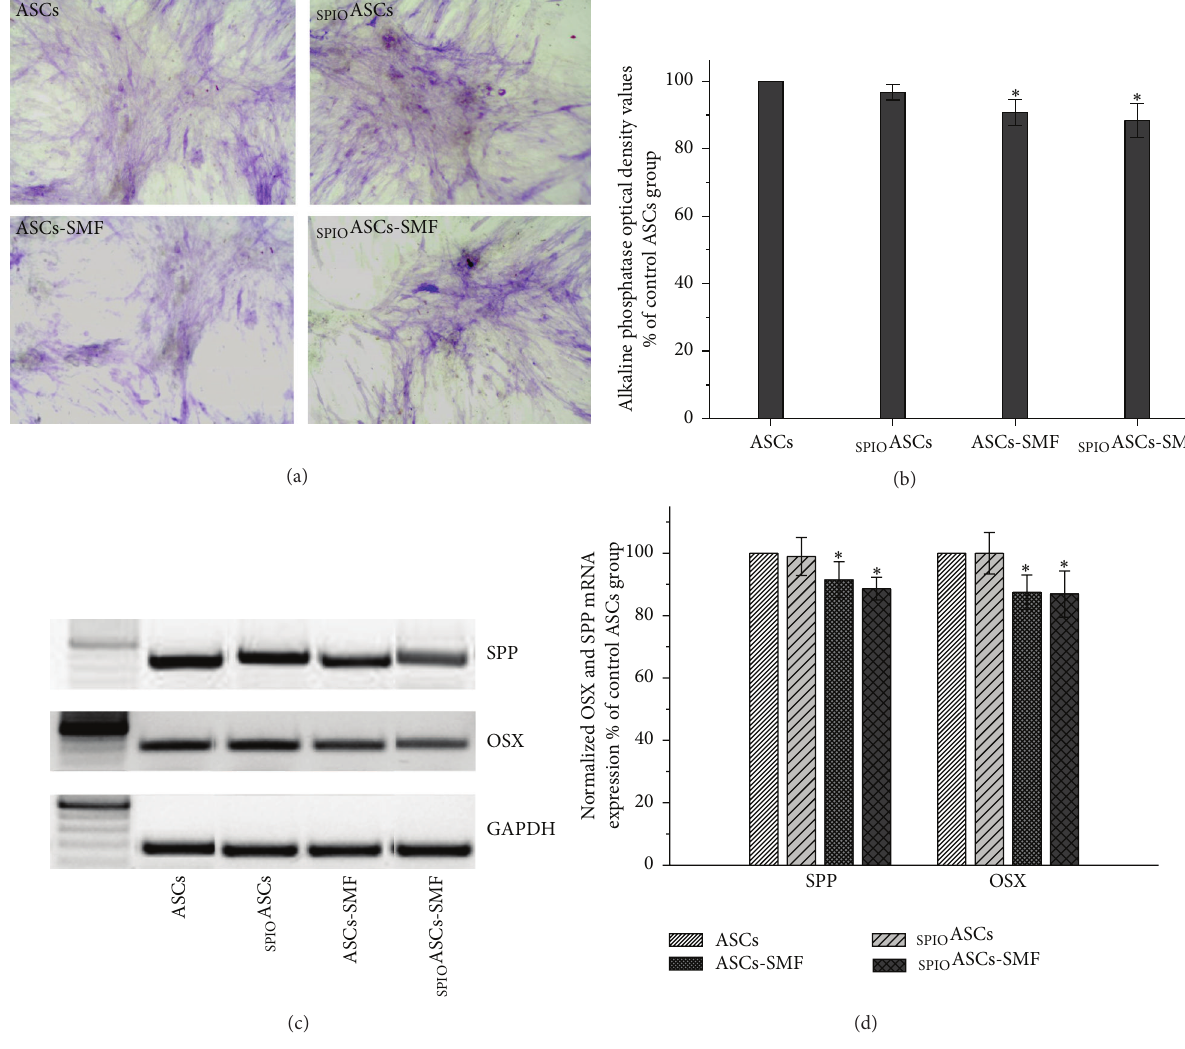
Figure 7: Effect of seven-day exposure to 0.5 T SMF on osteogenic differentiation in ASCs and SPIO ASCs. (a) Representative results of histochemical staining for alkaline phosphatase. (b) Quantification after normalization to levels from control ASCs. The alkaline phosphatase optical density value was significantly lower in the ASCs-SMF and SPIO ASCs-SMF than in ASCs and SPIO ASCs. (c) Representative results of RT-PCR for SPP and OSX. (d) Quantification after normalization to levels from control ASCs. The expression of mRNA for SPP and OSX was significantly lower in the ASCs-SMF and SPIO ASCs-SMF than in ASCs and SPIO ASCs. Scale bar represents 100 𝜇 m. ∗ 𝑃 < 0.05 versus ASCs or SPIO